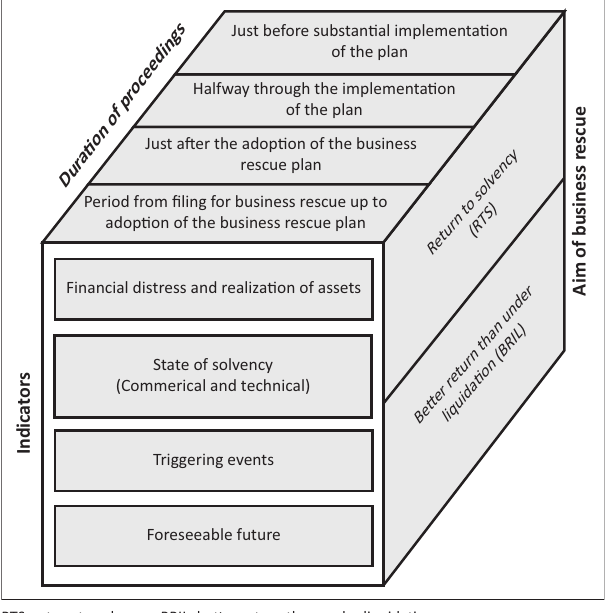
FIGURE 3: Conceptual model of business rescue contextualised indicators of going